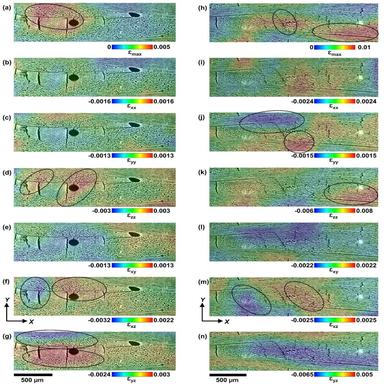
(a)-(g) Step1 (6 N) – Step6 (87 N) global DVC strains within material B tested at RT (B-RT-3) superimposed on the slice shown in a; (h)-(n) Step1 (17 N) – Step9 (113 N) global DVC strains within material B tested at 1050 C (B-1050-2) superimposed on the slice shown in. The strains were calculated prior to crack formation but are plotted on XCT slices showing fracture cracks to highlight correlation between localised strain and crack distribution.